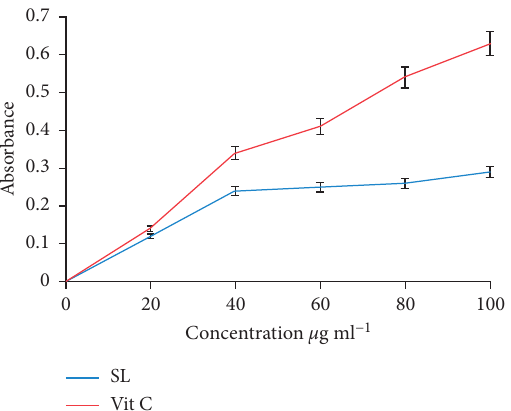
Figure 3: Reducing power of SL and Vit C Vit. C x � 397.608; R 2 � 0.9809. SL: x � 931.197; R 2 �